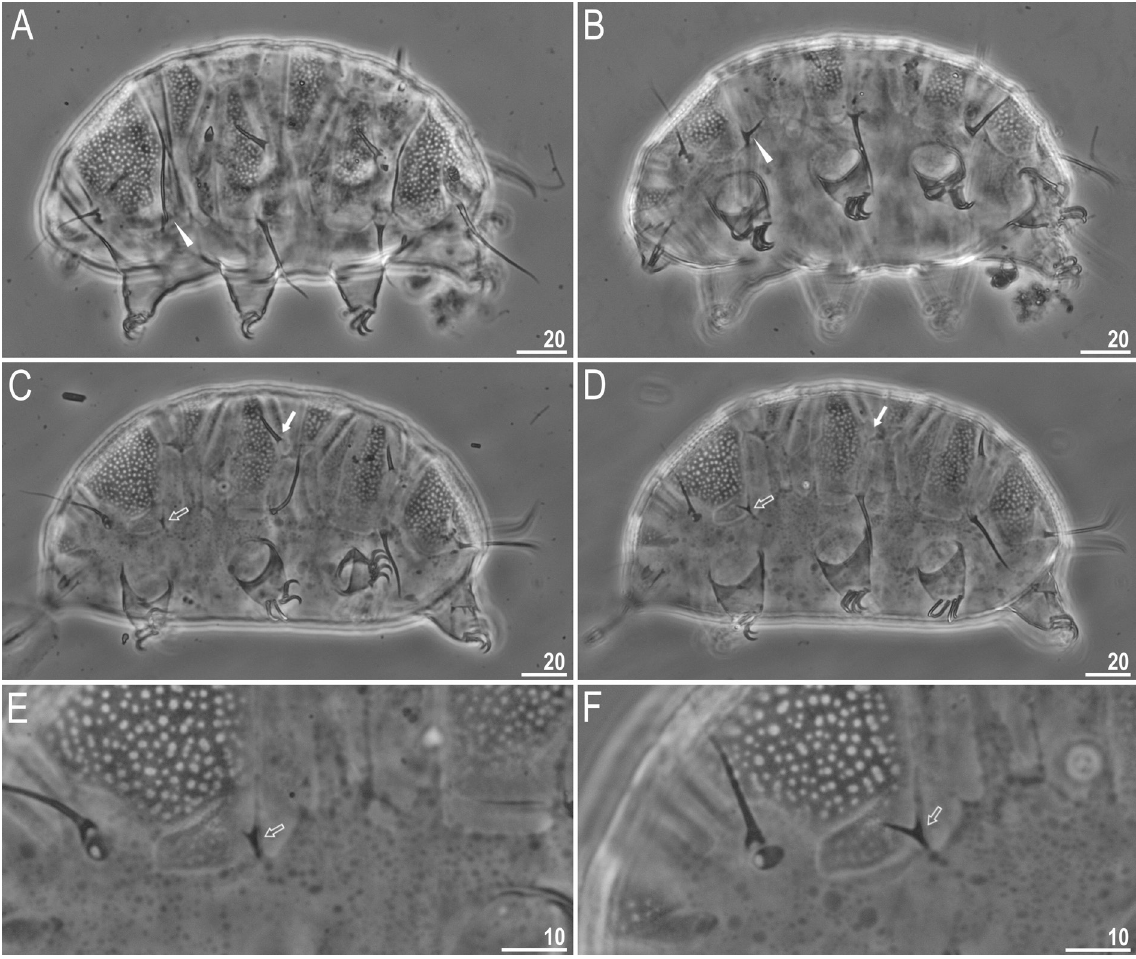
Fig. 6. Echiniscus quadrispinosus Richters, 1902, juvenile. A–B . Lateral view of the animal with appendage B present only on one side of the body (arrowhead) (chaetotaxy: A-B-C-C d -D-D d -E ). C–D . Lateral view with appendage C d present only on one side of the body (filled arrows) and two short spines present instead of appendage B (empty arrows). E–F . Close-up to the two short spines present instead of appendage B (empty arrows). All PCM. Scale bars in micrometres